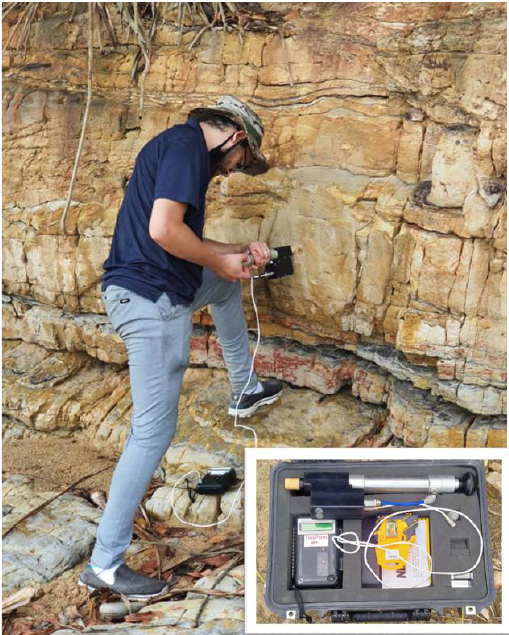
Figure 6. Measuring air permeability using the Tinyperm II portable permeameter.